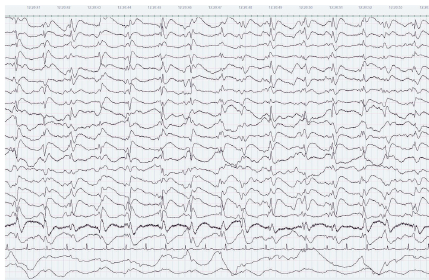
Figure 1: Continuous EEG registration, showing typical semiperi- odic sharp-wave complexes with intervals of about 1